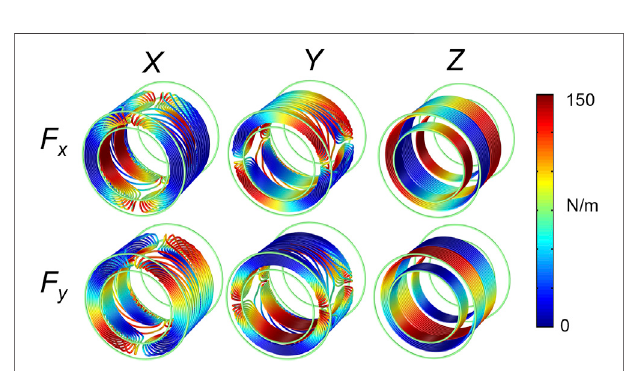
FIGURE 3 | Lorentz forces on the gradient